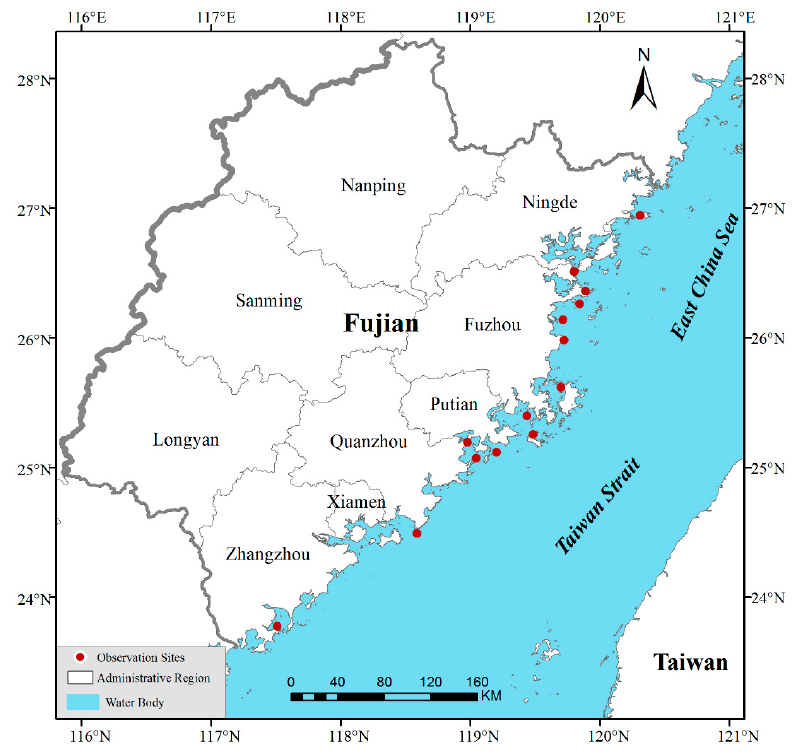
Figure 1. The location of Fujian (China) and the spatial distribution of in situ observation stations in Fujian’s coastal